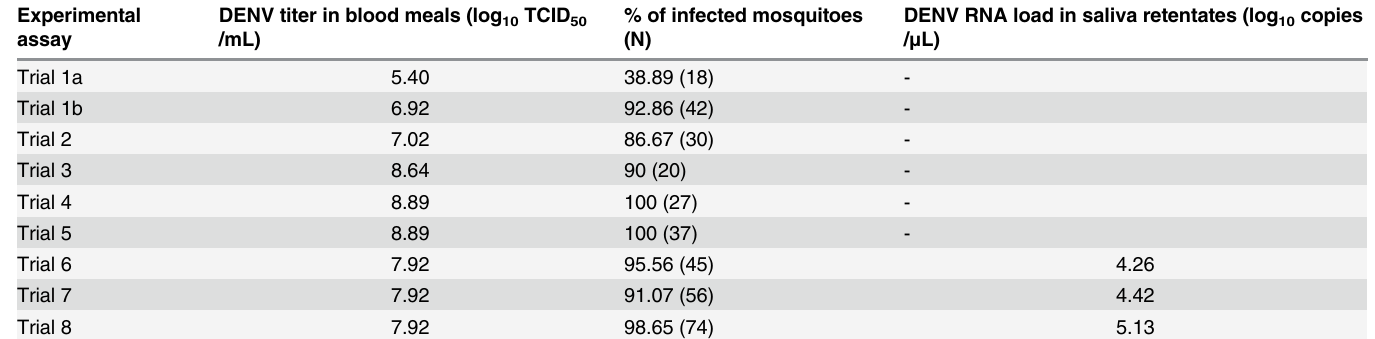
Table 1. Infected Aedes aegypti rate (%) at 14 days post-intake of an artificial infectious blood-meal prepared either with initial (trial 1a) or CFD- concentrated DENV supernatants (trials 1b-8). Experimental